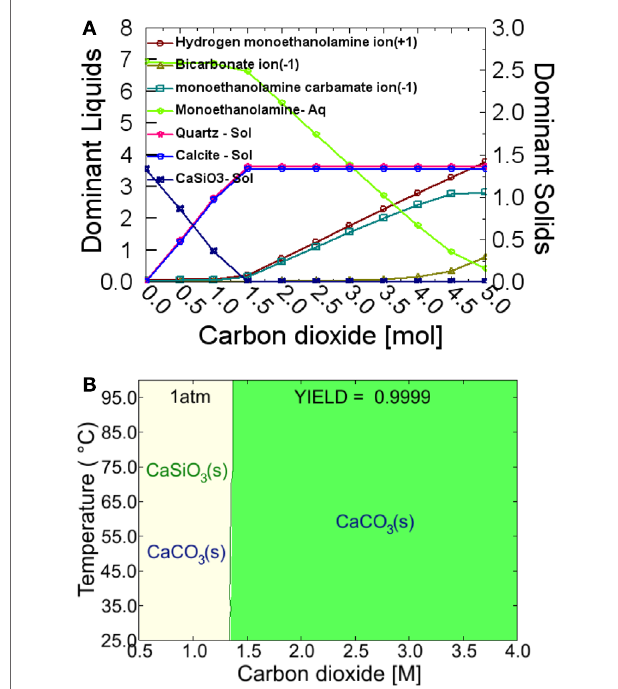
FigUre 1 | Thermodynamic simulation from Oli software . (a) Dominant liquid species and dominant solids as function of CO 2 concentration at 60°C in 7.00M MEA – 1.31M CaSiO 3 – 0.02M Calcite – 0.05M Quartz system; and (B) Equilibrium phase diagram between 25 and 100°C and at one atmosphere pressure in 7.00M MEA – 1.31M CaSiO 3 – 0.02M Calcite – 0.05M Quartz system. Phase stability and yield diagrams for the carbonation of CaSiO 3 in the system of 7.00M MEA – 1.31M CaSiO 3 – 0.02M Calcite – 0.05M